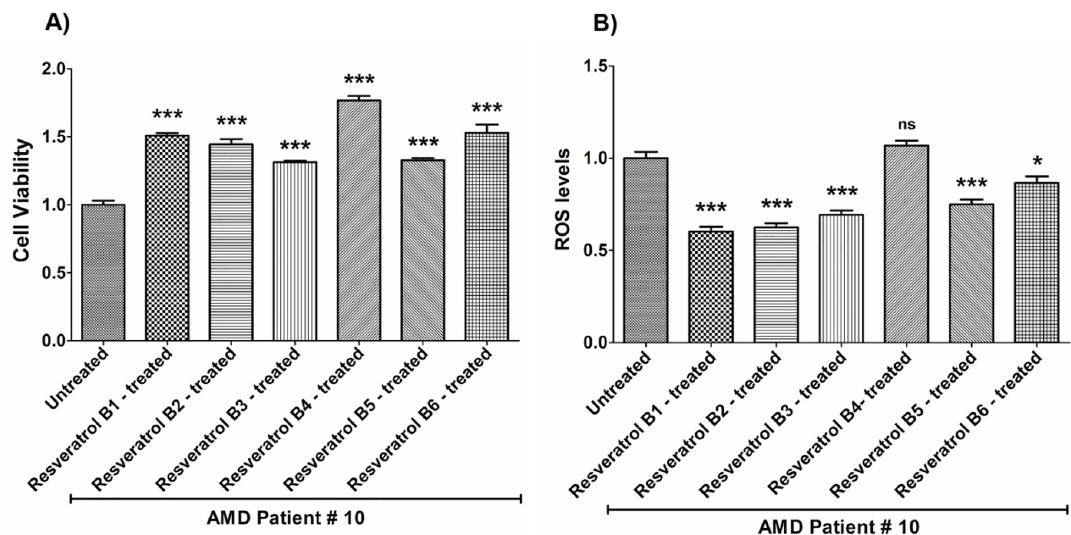
Figure 11. E ff ects of resveratrol formulations on cell viability ( A ) and ROS levels ( B ) in AMD patient #10.